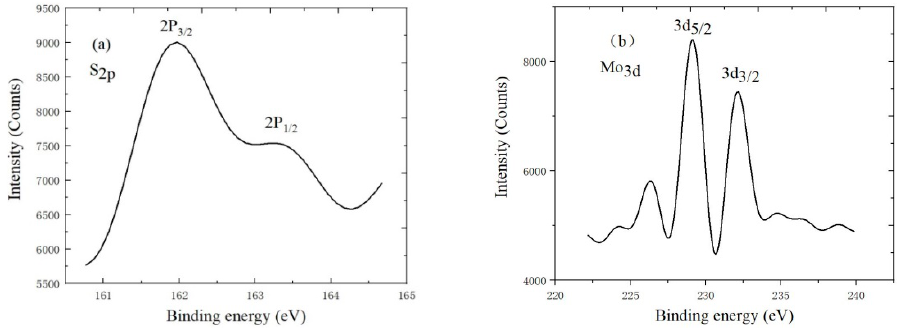
Figure 7. ( a ) S 2p ; ( b ) Mo 3d of X-ray photoelectron spectroscopy.